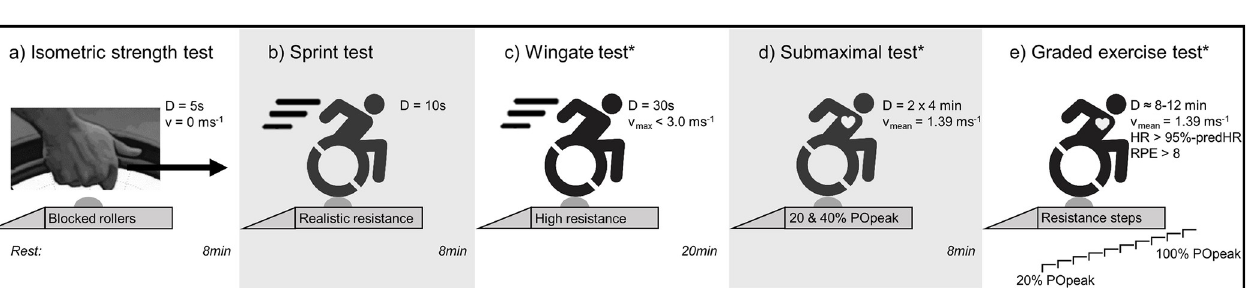
PLOS ONE | https://doi.org/10.1371/journal.pone.0274255 September 6,